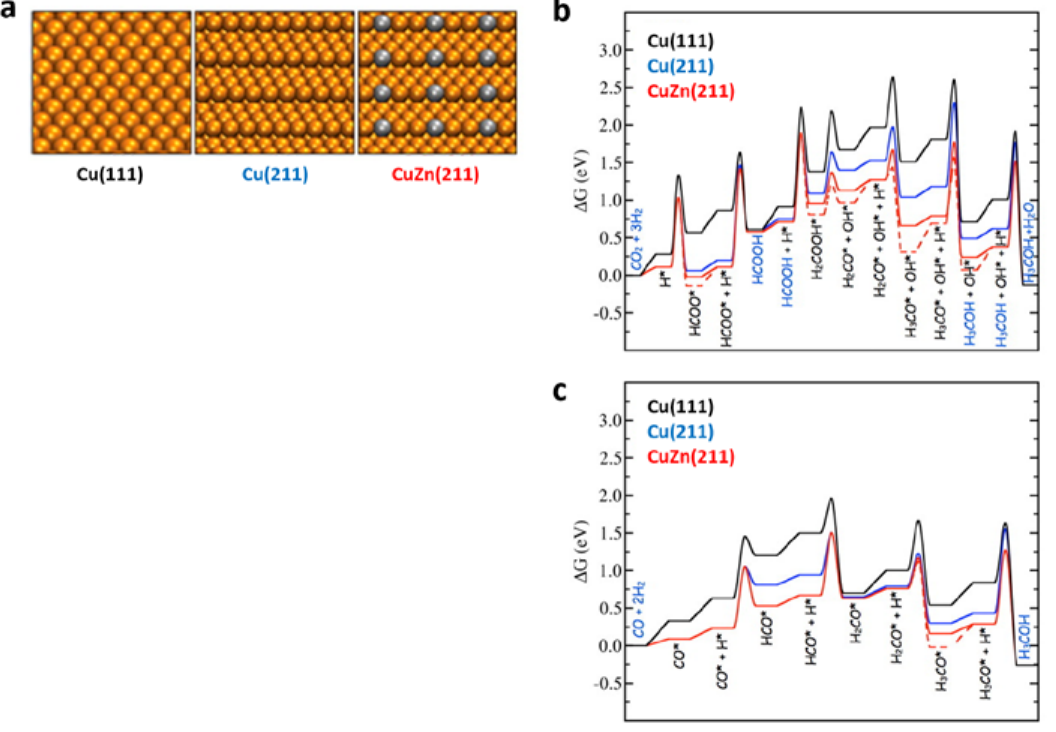
Figure 4. The Cu(111), Cu(211), and CuZn(211) facets as viewed from perspective ( a ); Gibbs free energy diagram obtained from DFT calculations for CO 2 ( b ) and CO ( c ) hydrogenation on close-packed (black), stepped (blue), and Zn substituted steps (red Intermediates marked with a star are adsorbed on the surface. Reprinted with permission from [102], AAAS, 2012.